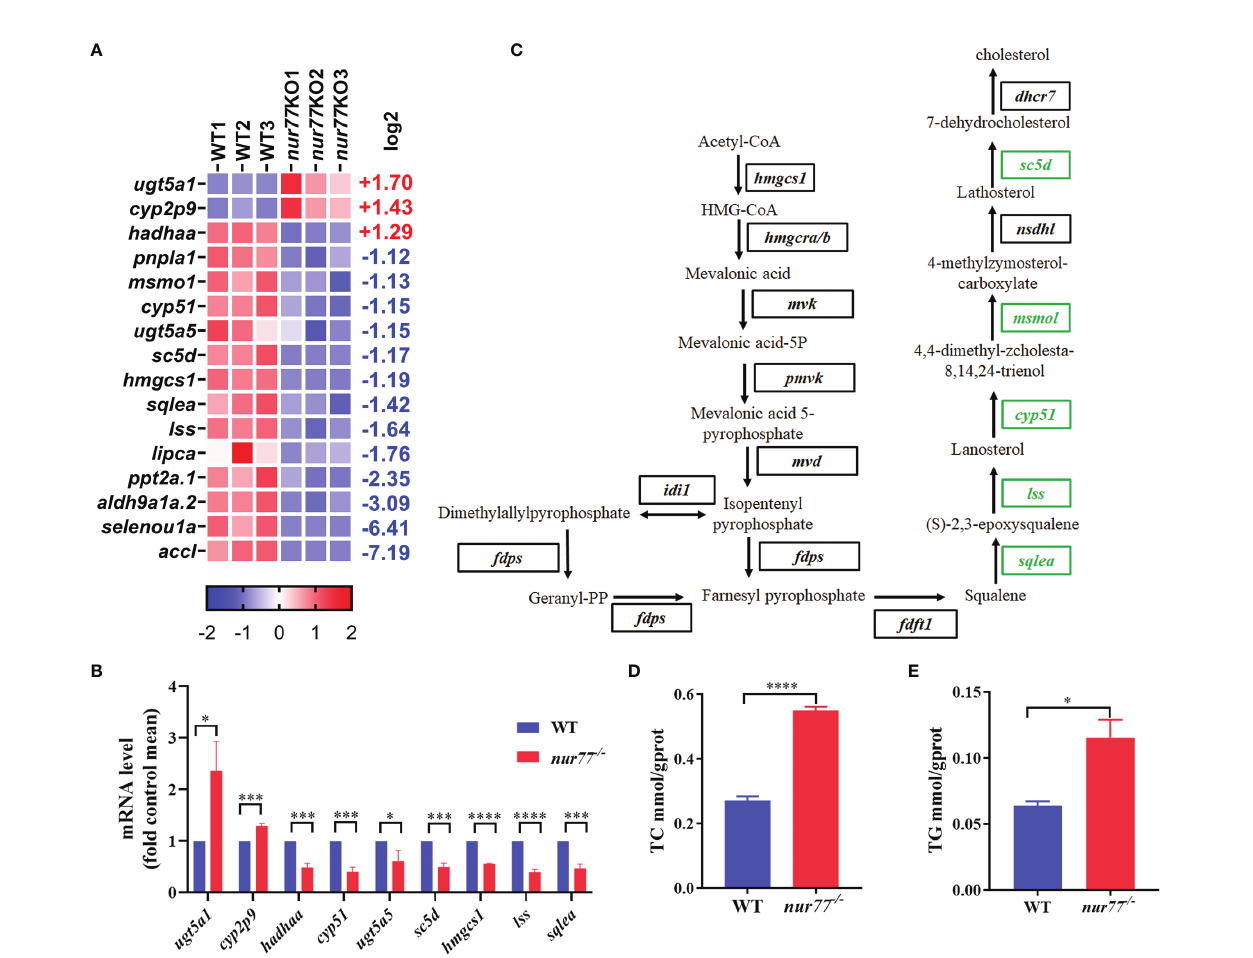
FIGURE 4 | Nur77 regulates lipid metabolism in zebra fi sh larvae. (A) Heatmaps of transcripts in lipid metabolism enrichment. Colors represent high (red), low (blue), or average (white) expression values based on Z-score-normalized fragments per kilobase per million mapped read (FPKM) values for each gene. The Z-score indicators are shown under each map. The fold change (log2) is shown on the right. (B) The validation of the expression levels of differentially expressed genes by qRT-PCR analysis in the categories of lipid metabolism ( n = 3). (C) Disturbed cholesterol biosynthesis. Blocks represent transcript-encoded enzymes. Green blocks represent downregulated genes, and black blocks represent unchanged genes. (D) The whole-body cholesterol (TC) contents of WT and nur77 − / − zebra fi sh ( n = 3). (E) The whole-body total triglyceride (TG) contents of WT and nur77 − / − zebra fi sh. Results are represented as means with standard errors ( n = 3); * p < 0.05, *** p < 0.001, **** p < 0.0001 by t